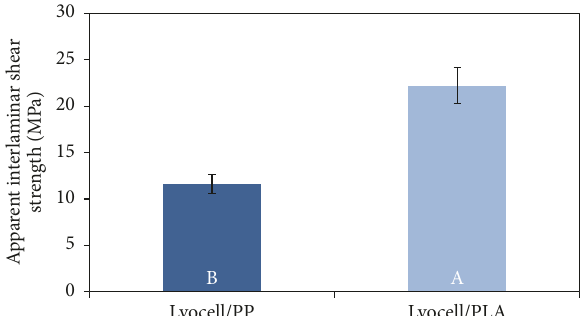
Figure 4: Apparent interlaminar shear strength (ILSS) of CM lyocell/PP and IM lyocell/PLA composites measured with double-notched tensile tests (mean value standard deviation, different letters show significant differences).